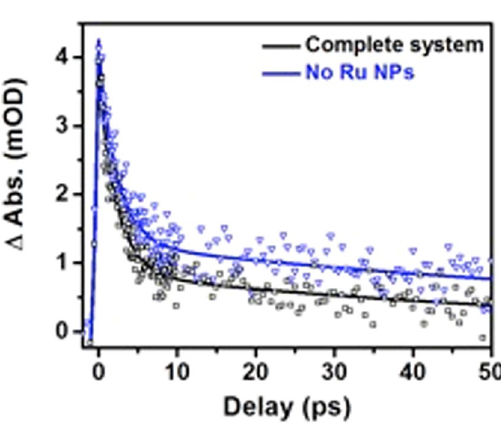
Figure 5. Effect of adding the catalyst to the ultrafast transient absorption signal. Kinetic traces extracted at 795 nm from transient absorption spectroscopy measurements upon excitation at 405 nm for the complete system and in the absence of Ru NPs (hydrog en evolution catalyst). The instrument response function is ca . 200